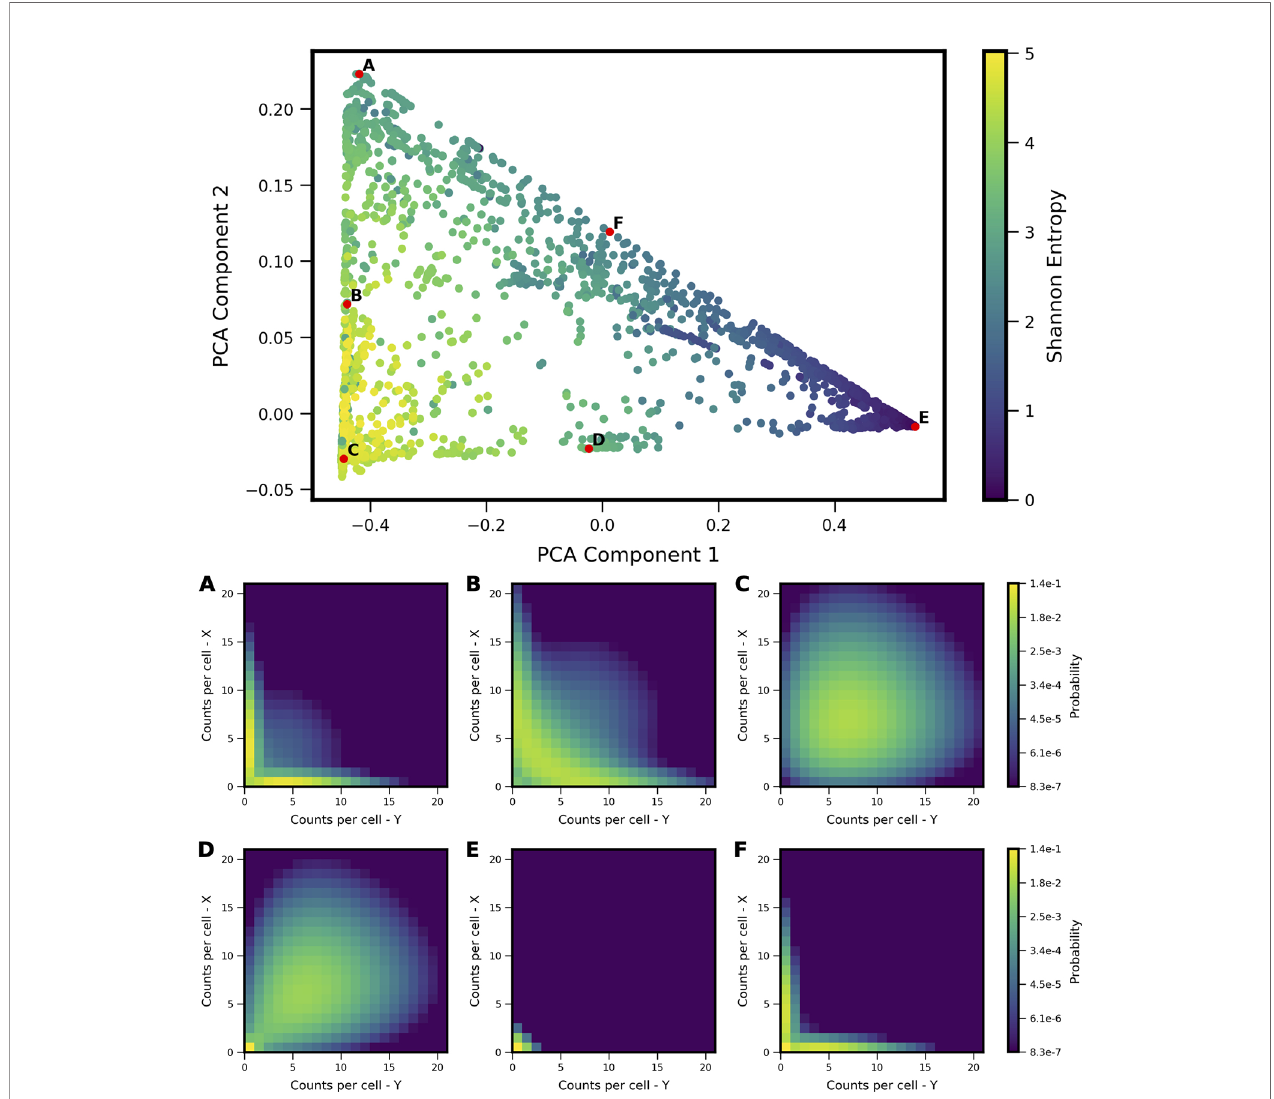
FIGURE 2 | Shape-space of simulated Two-Gene Flex coexpression landscapes analyzed by Principal Component Analysis (PCA). Coexpression landscapes were computed for 34,097 unique two-gene stochastic network models with varying regulatory interactions and kinetic rate parameters (see Model schematic in Figure 1 ). (Top) All model landscapes projected onto the fi rst two principal components. Each dot corresponds to one model, colored by the model's Shannon Entropy. (Bottom) Representative quasipotential landscapes f (n) (see Methods) of individual models from different regions of PCA component-space. color of each discrete grid space in {x,y} corresponds to computed probability (in log-scale) to fi nd a single cell with the corresponding numbers of {x,y} transcripts. Each landscape is labeled (A – F) to indicate the corresponding point where it appears in PCA space